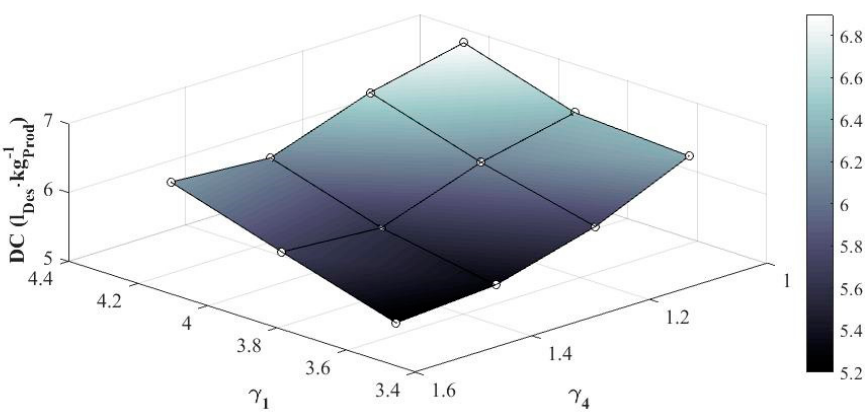
Figure 12. Desorbent consumption performance against γ 1 and γ 4 at the optimum γ 2 and γ 3.